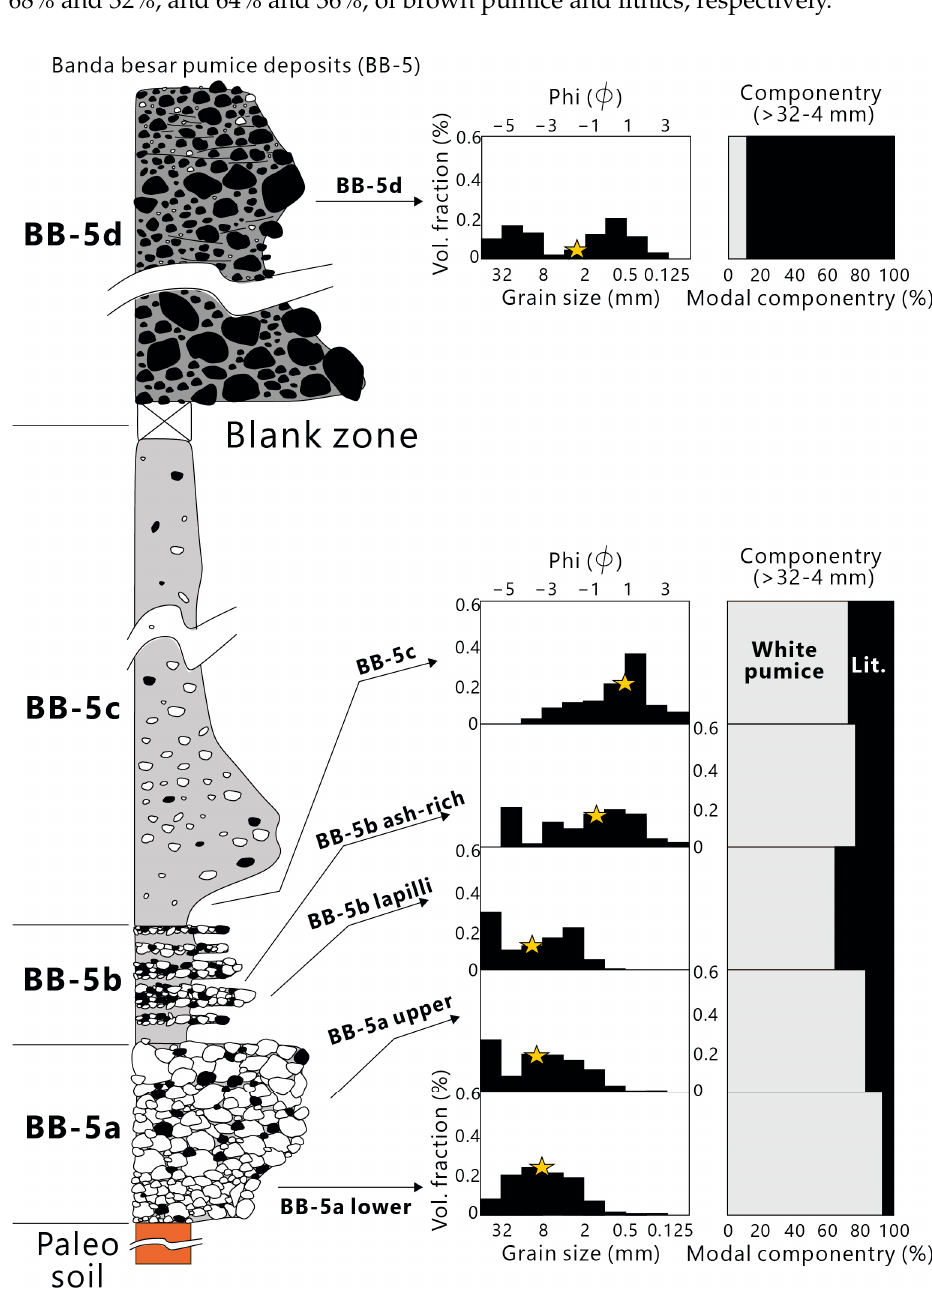
Figure 7. Composite stratigraphy, grain size distributions (GSDs), and componentry result of the Banda Besar pumice deposits (BB-5). Star symbols in GSD histograms represent the median size. Grey and black colors in componentry represent white pumice and lithics.